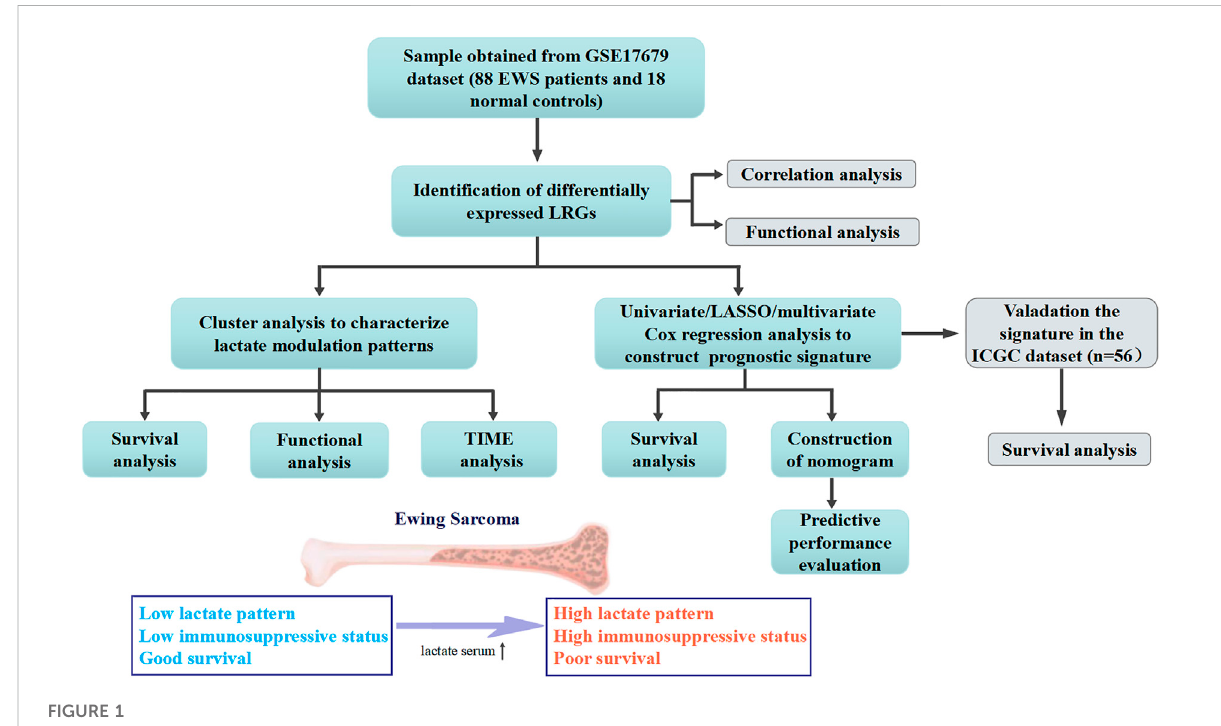
FIGURE 1 Work fl ow diagraph of the data analyzing